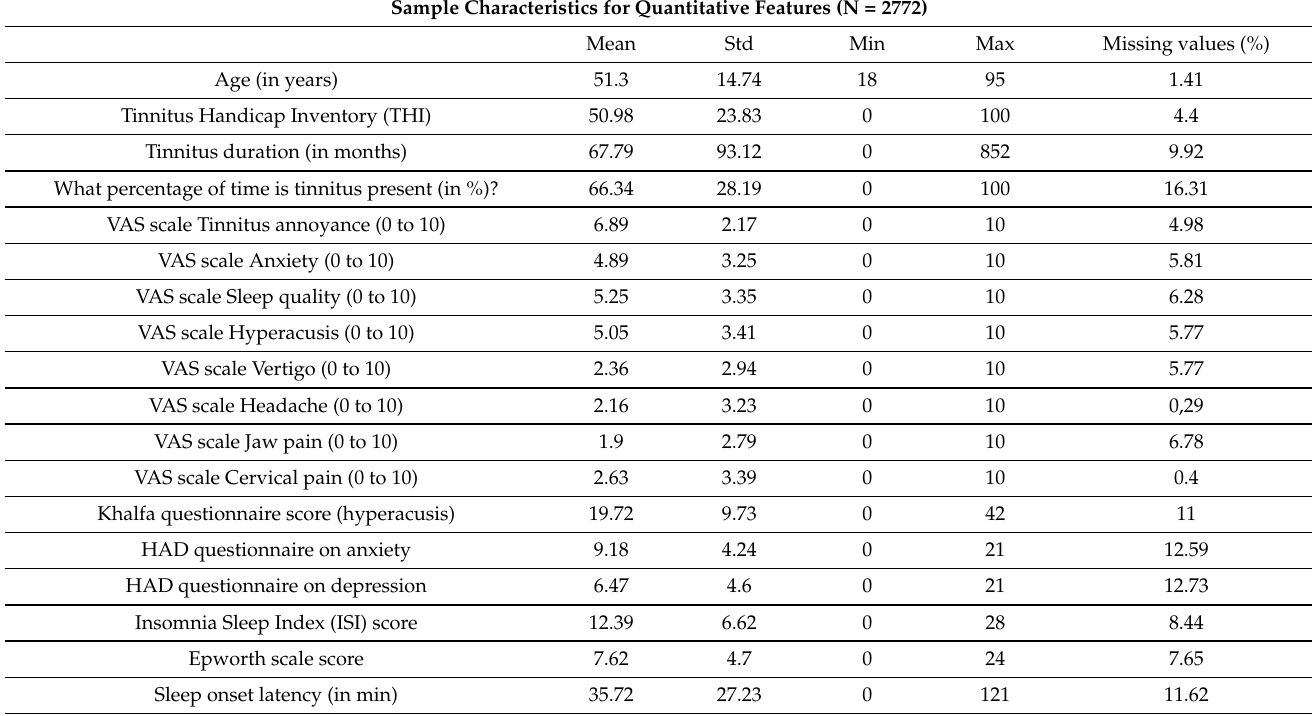
Table 2. Sample characteristics’: quantitative features of the preprocessed